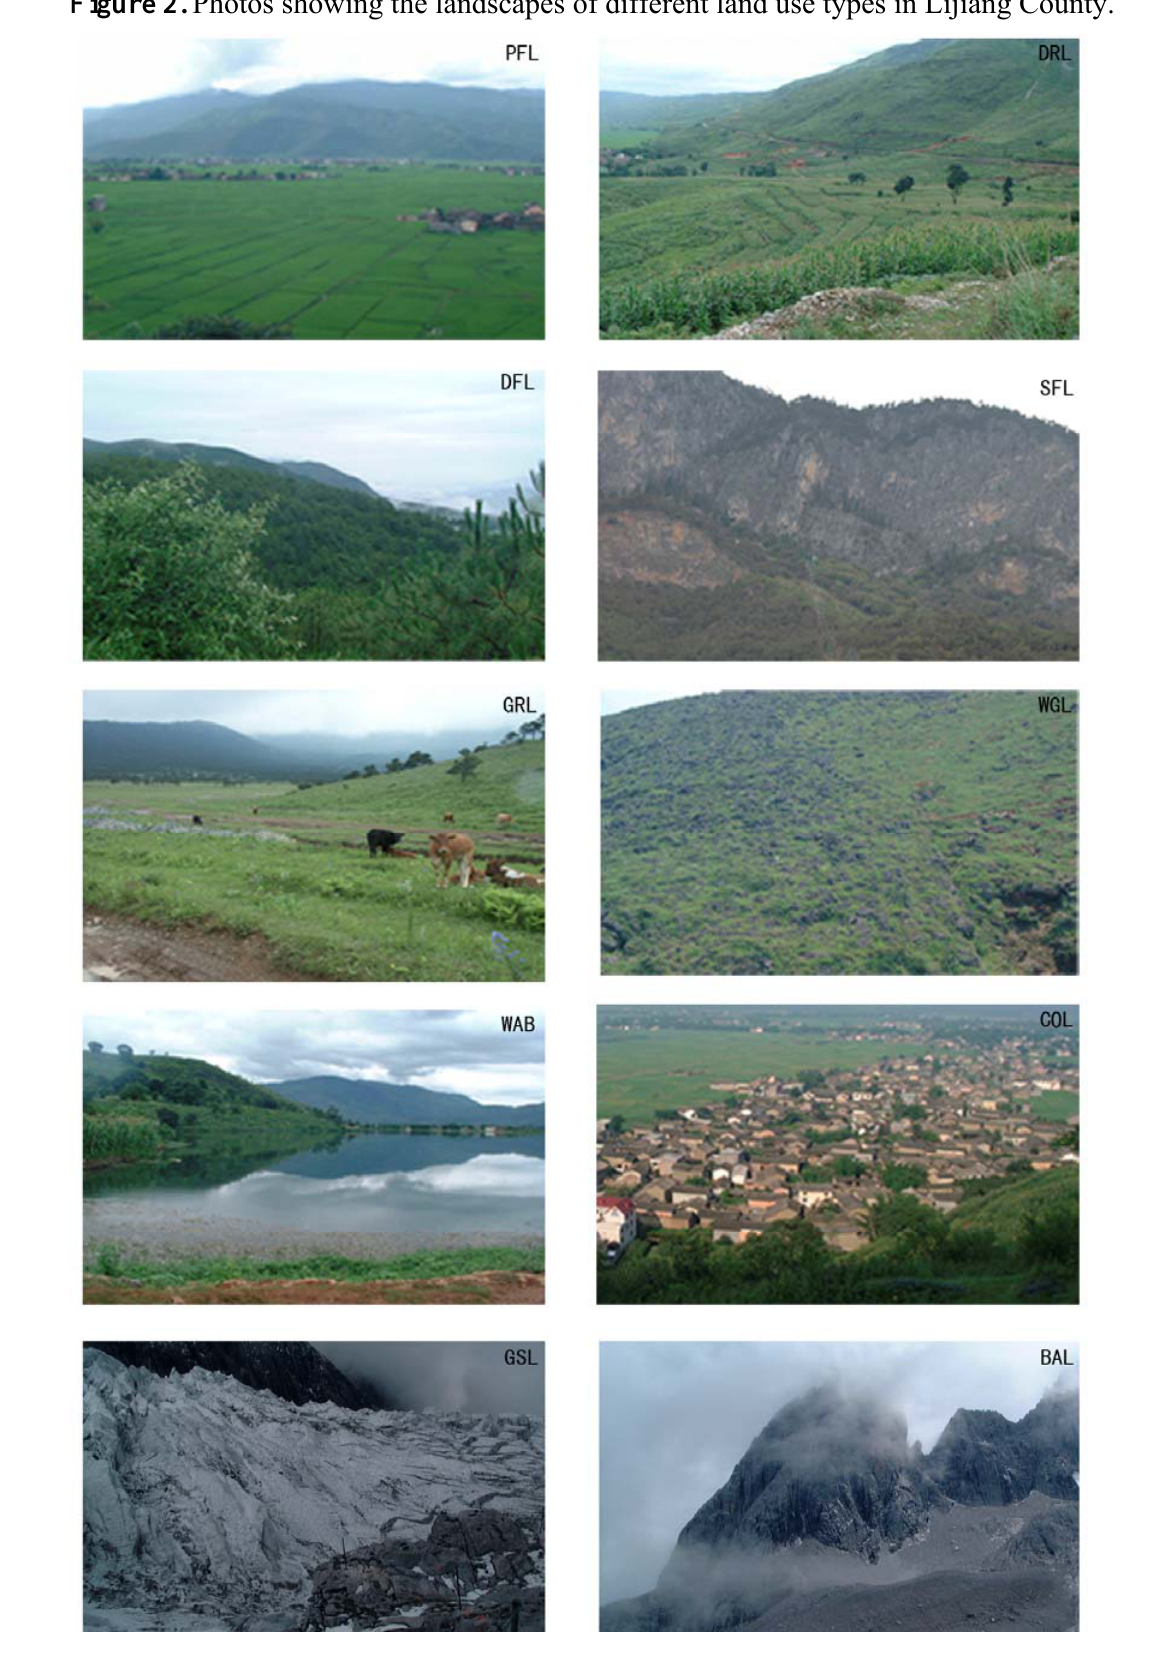
Figure 2. Photos showing the landscapes of different land use types in Lijiang